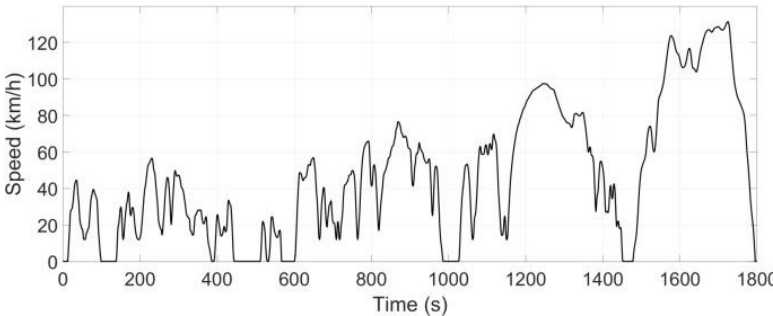
Figure 5. NEDC test cycle.